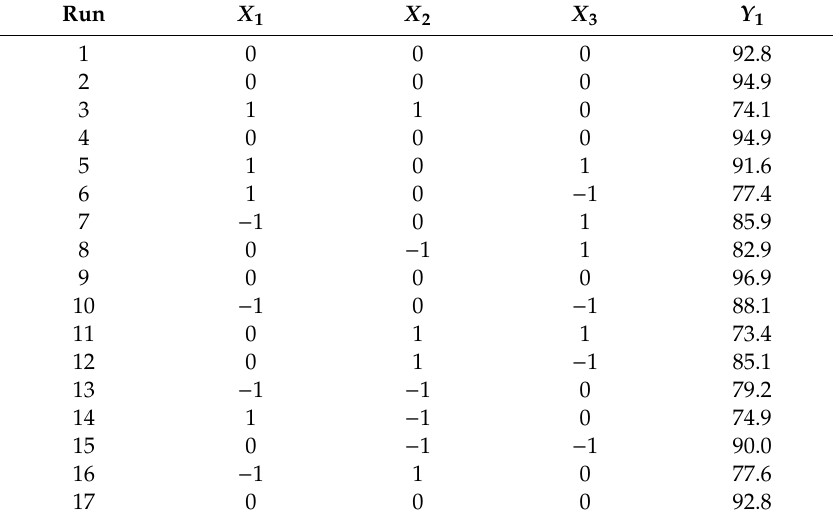
Box–Behnken experimental design matrix and response of dependent variable for D-cyphenothrin